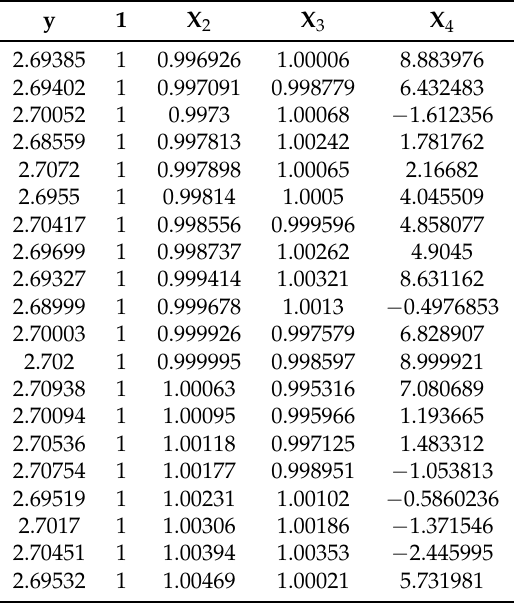
Table 1. Data set applied by Belsley [1].